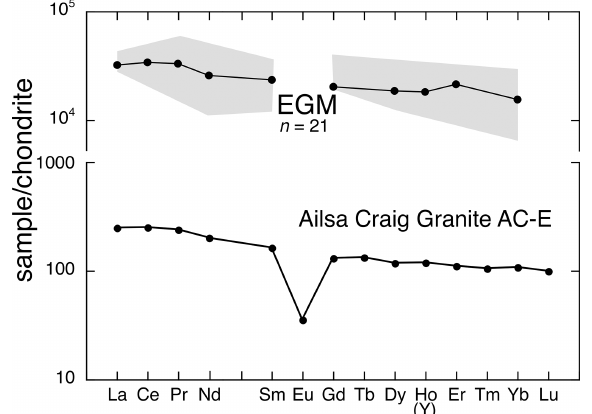
Figure 16. Chondrite-normalized plot comparing the REE pattern from Ailsa Craig granite AC-E (Govindaraju, 1987; Table 2) with measured range and average REEs from EGMs in this study (sample DV24828). Ho plotted in granite and Y plotted for Ho in EGMs. Normalizing factors from McDonough and Sun